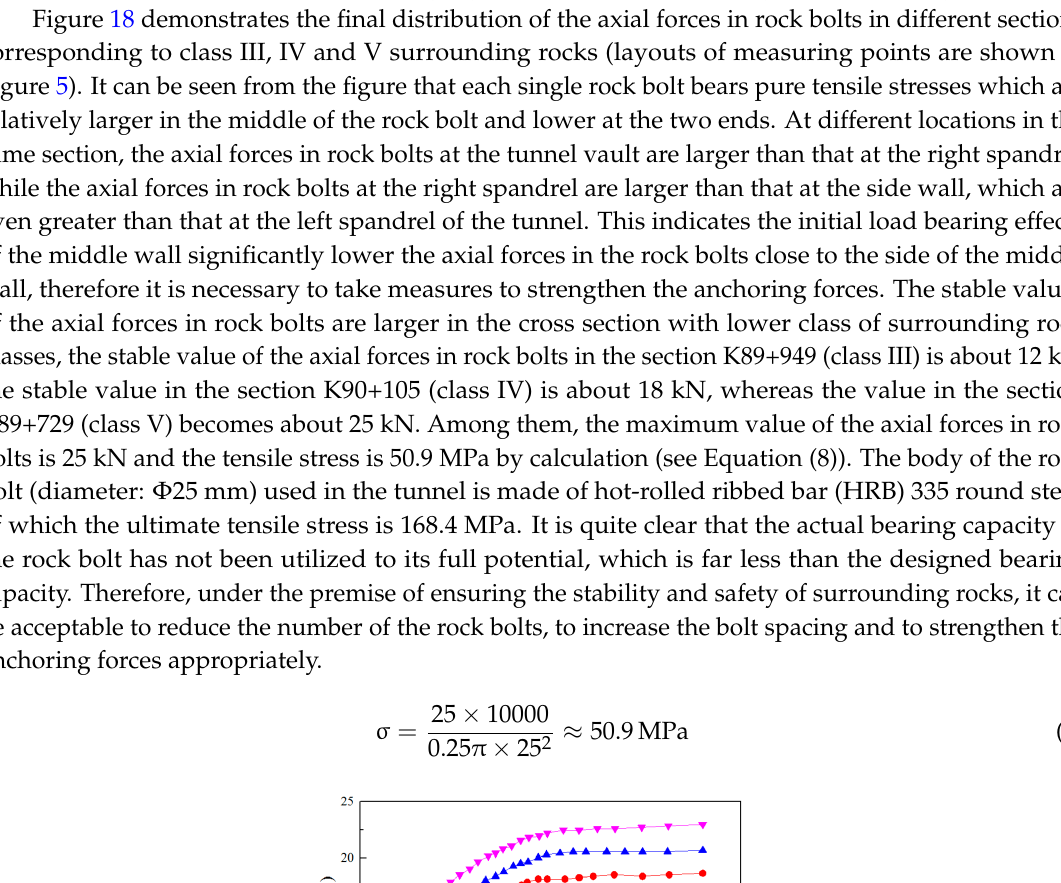
Figure 17. Time history plots of the axial forces in rock bolts at location C in the K89+729 section. Figure 18. Final distribution of the axial forces in rock bolts in different sections respectively corresponding to class III, IV and V surrounding rocks. The values in the figure are the axial forces in rock bolts in class V surrounding rocks. 3.4. Internal Forces in Steel Arches Figures 19 and 20 present the dynamic evolution of the internal forces in steel arches (including the axial forces and the absolute values of the bending moments) at different locations in the K89+729